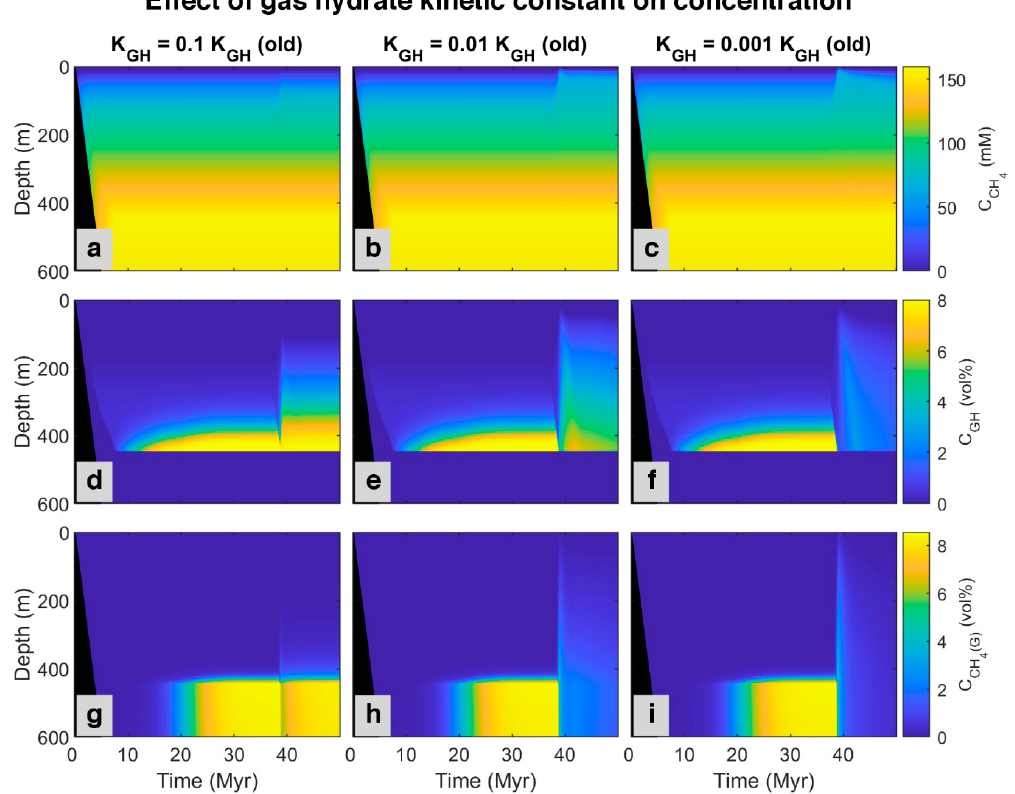
Figure 8. Simulated spatial and temporal concentration profile at different gas hydrate kinetic constant. First row: ( a – c ) Dissolved methane in pore water. Second row: ( d – f ) Methane hosted in gas hydrate phase. Last row: ( g – i ) Free gas.